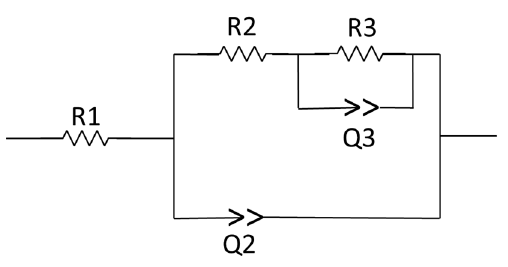
Figure 5. Equivalent circuit used for fitting of EIS data.